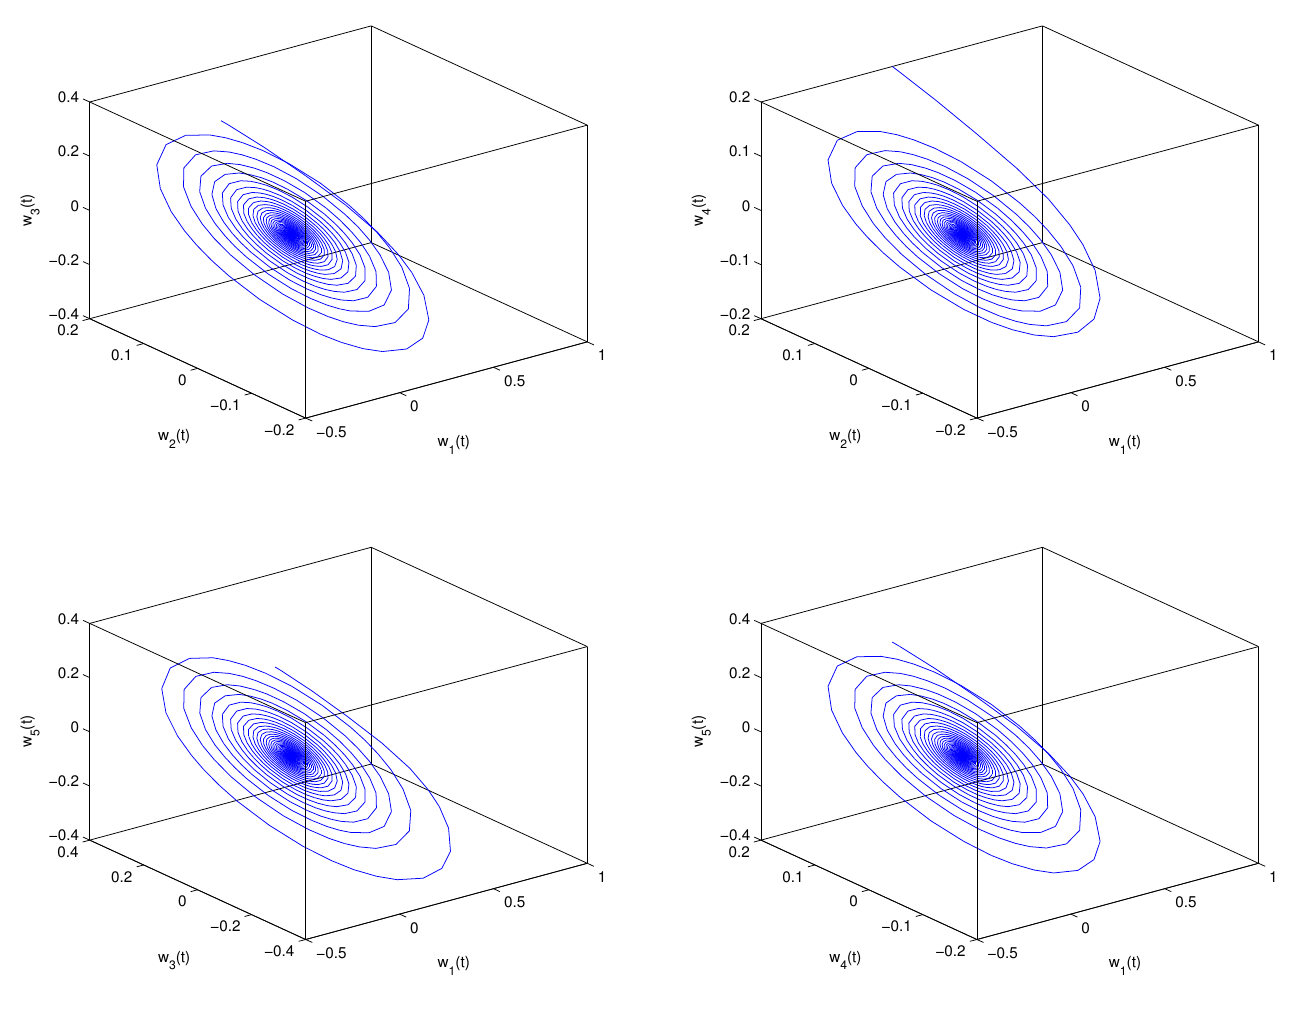
Figure 15. Matlab simulation outcomes for system (73) when ϑ = 0.3 < ϑ ∗ = 0.32. The null equilibrium point E ( 0,0,0,0,0 ) of system (73) keeps locally asymptotic stability.